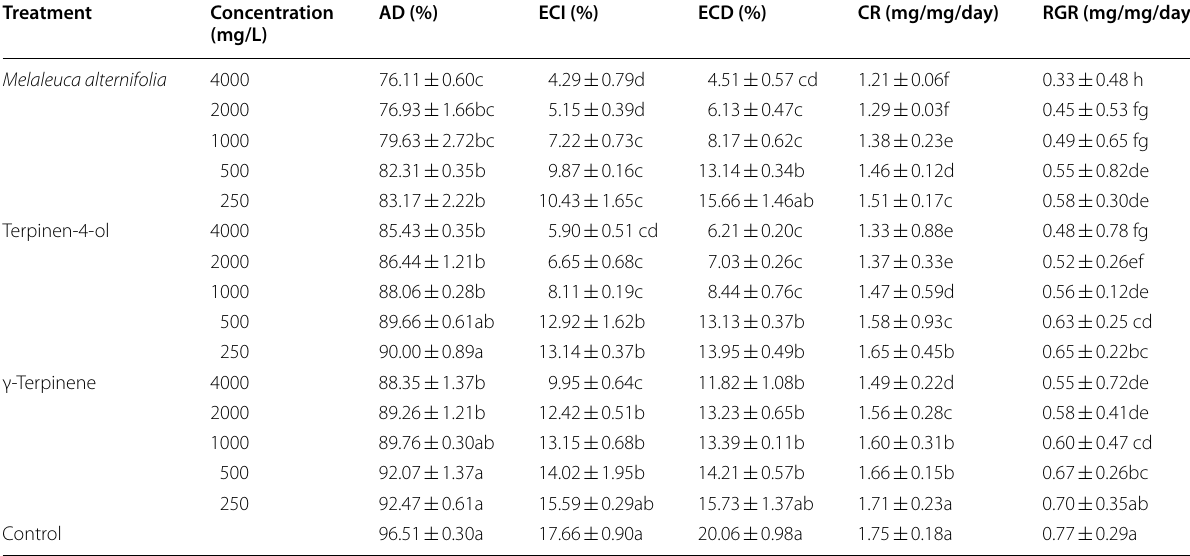
Means SE within the same column having the same letter are not statistically different from each other, P ± replicates of 10 larvae each AD approximate digestibility, ECI efficiency of conversion of ingested food, ECD efficiency of conversion of digested food, CR consumption rate, RGR relative growth rate